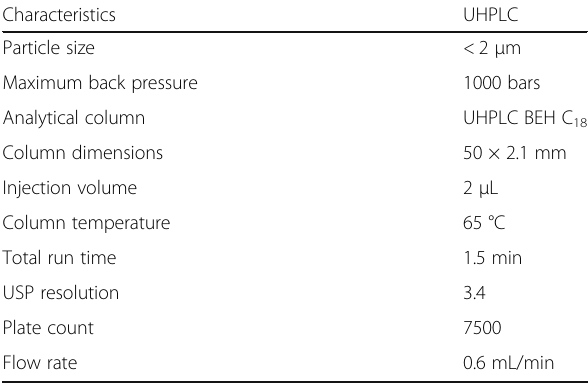
Table 1 Acceptance criteria for